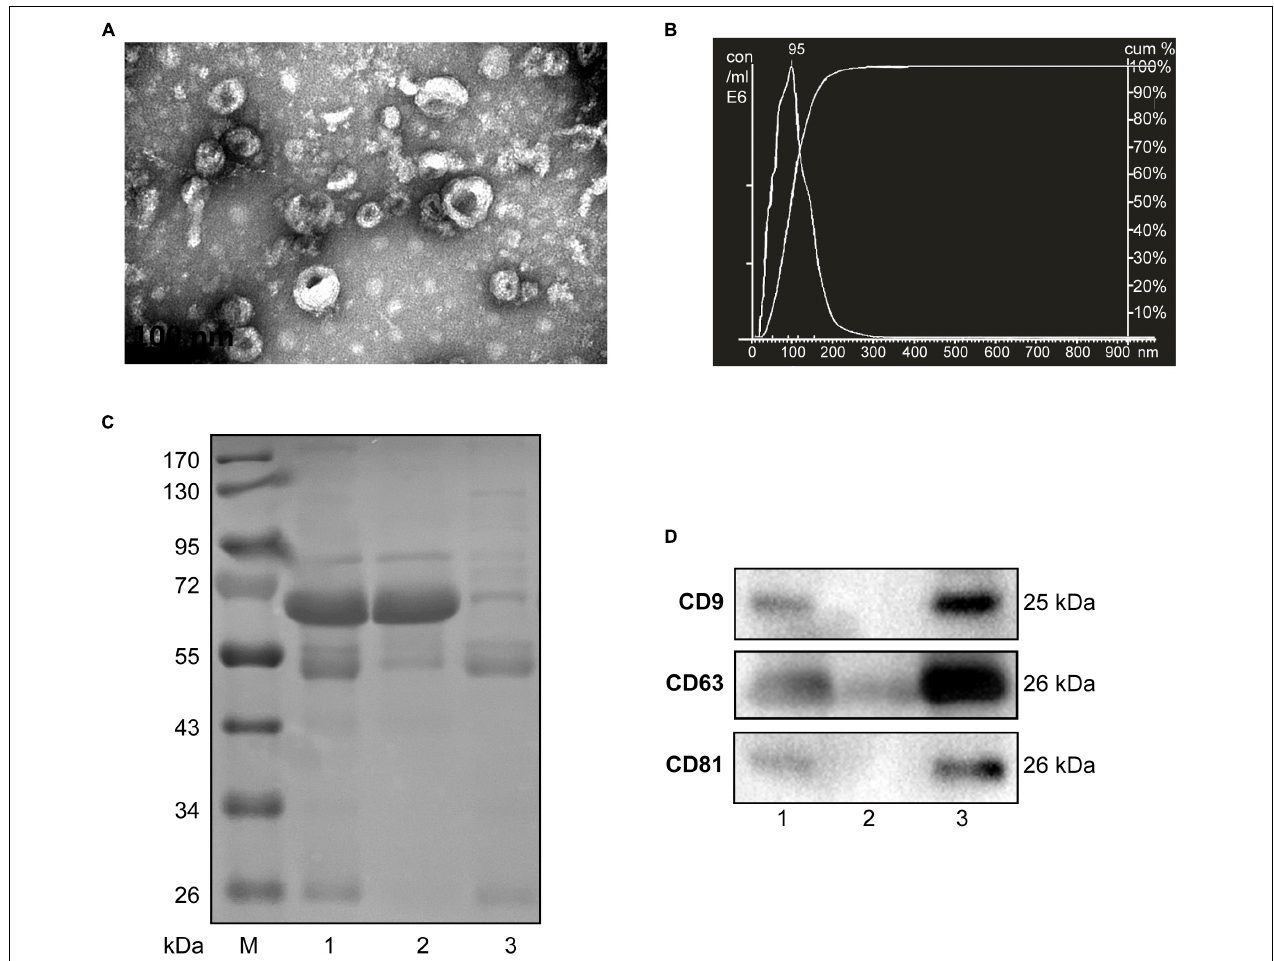
FIGURE 1 | Characterization of sEVs isolated from human serum. (A) The TEM image shows the spherical morphology of sEVs with a diameter of approximately 100 nm, bar = 100 nm. (B) NTA analysis plot illustrates the size distribution and concentration of the sEVs isolated human serum. (C) Proteins from serum, sEVs-depleted serum, and sEVs were separated by SDS-PAGE and stained by Coomassie blue. 40 µ g proteins from serum and sEVs depleted serum were loaded. The amount of sEVs protein was adjusted by the serum volume corresponding to 40 µ g serum protein. (D) The expression of CD9, CD81, and CD63, markers of exosomes, was detected by western blotting. Lane 1: total serum; lane 2: sEVs-depleted serum; lane 3: serum